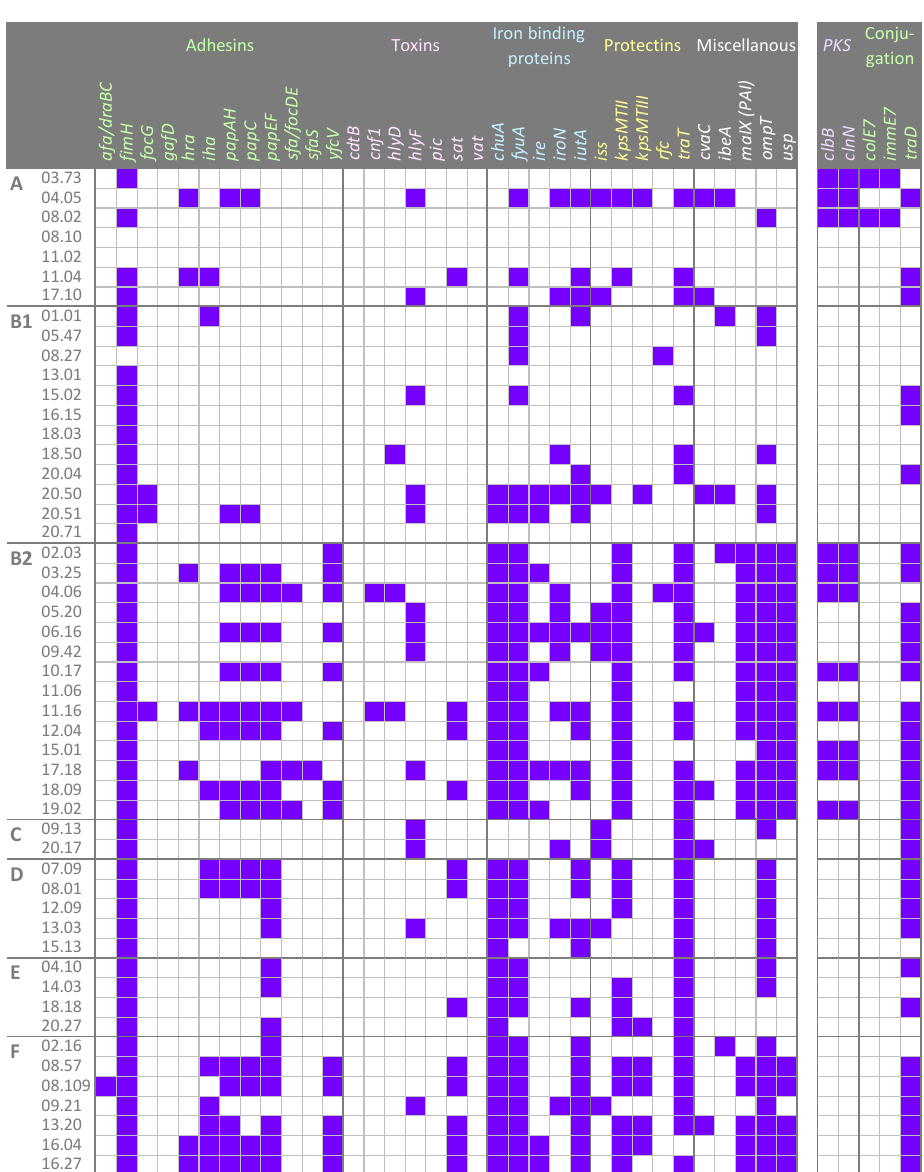
Figure 3. The pattern of genetic determinants in the 51 E. coli strains, ordered on the basis of their phylotypes. Virulence genes coding for adhesins, toxins, iron binding proteins, and protectins were screened. The presence of the pks pathogenicity island and other genes involved in the conjugation machinery were searched. Purple squares, presence; white squares, absence.